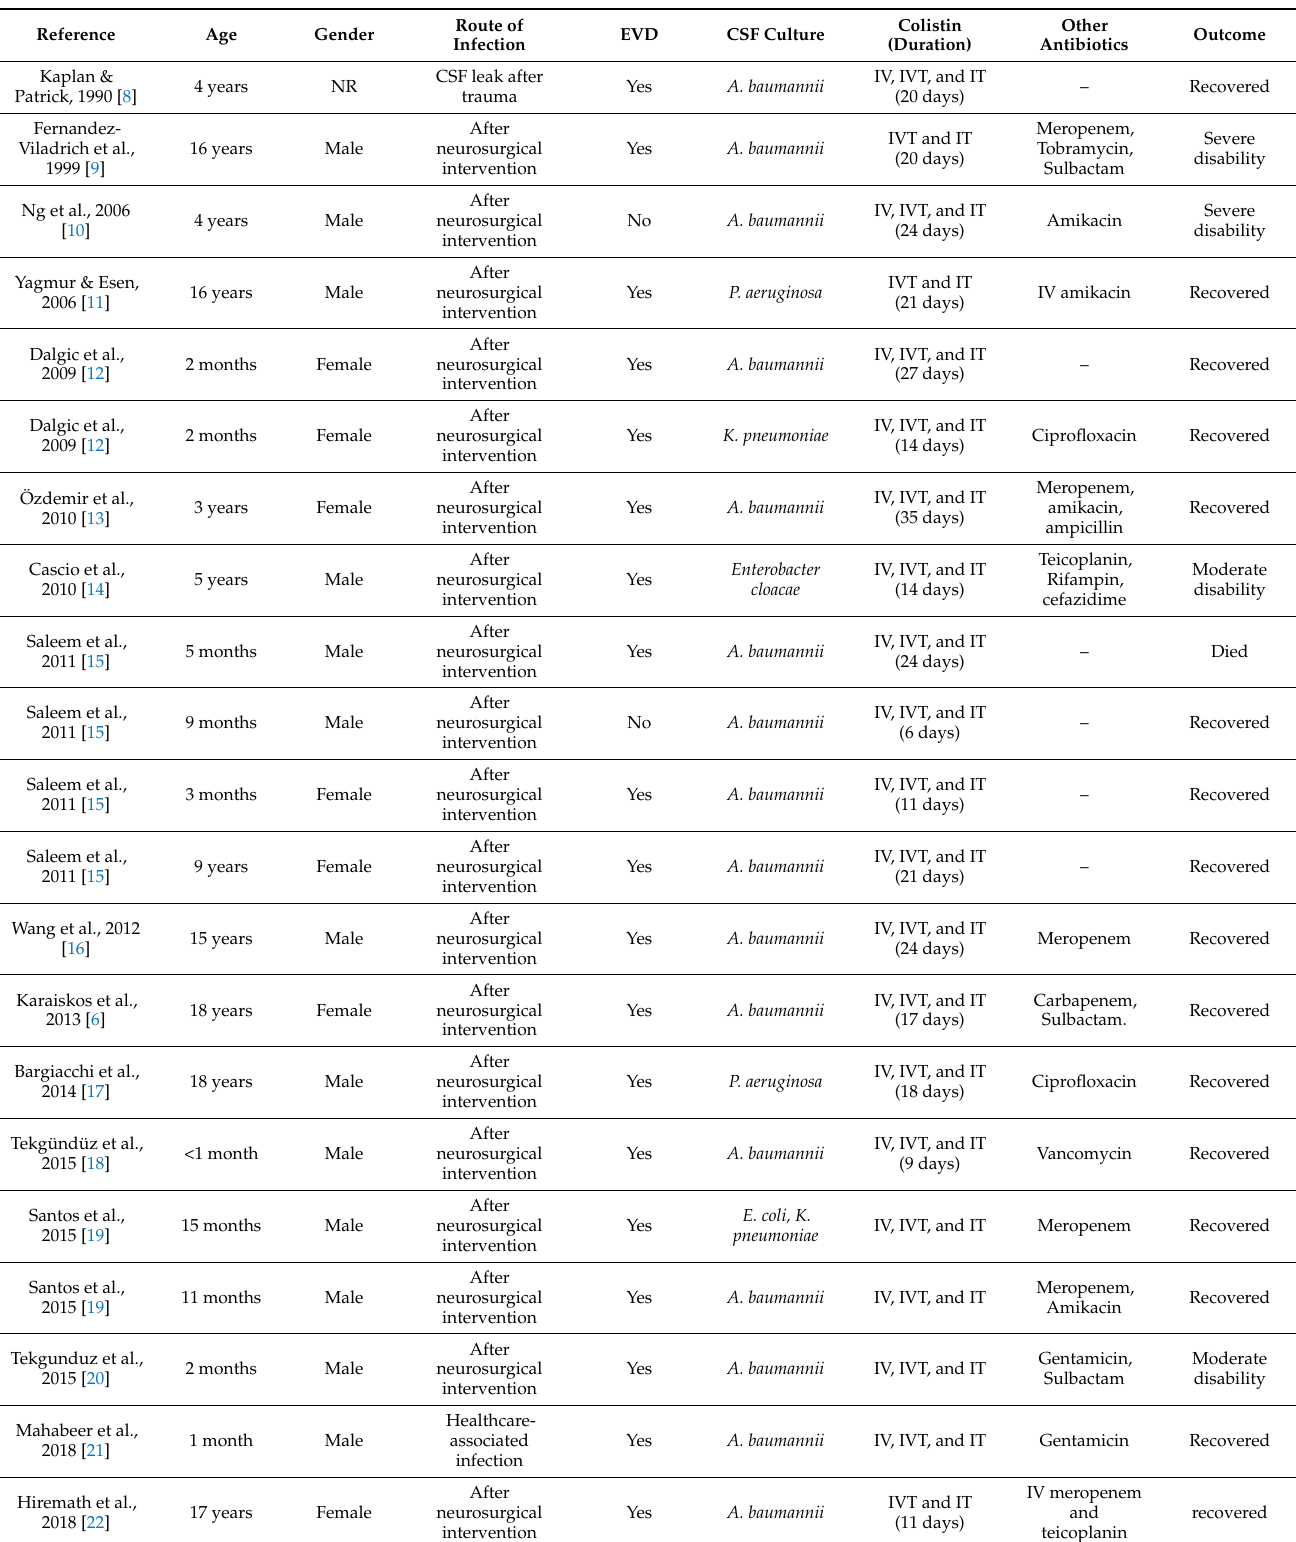
Table 1. Summary of the main findings of the included